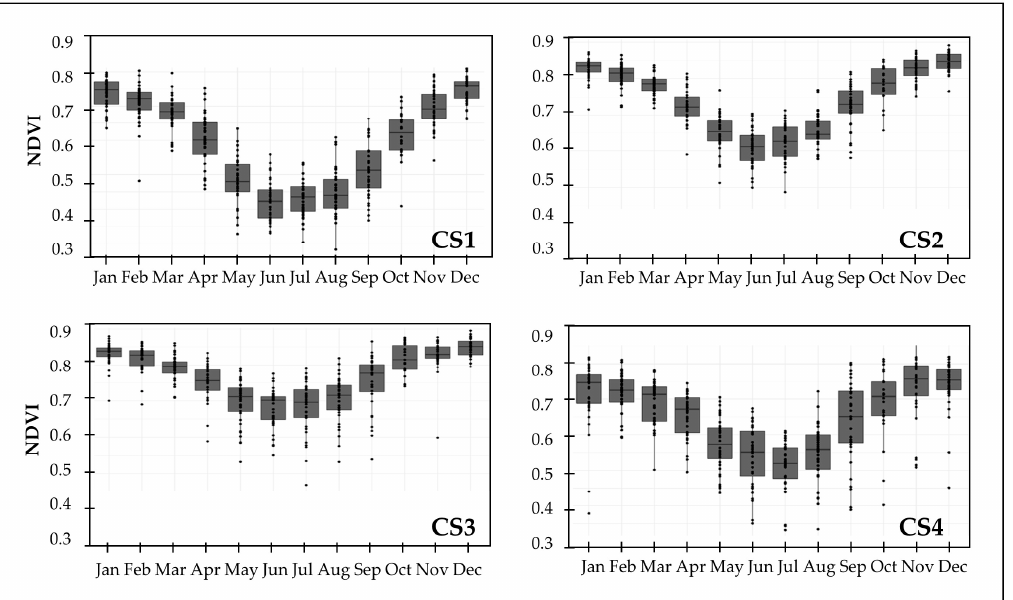
Figure 6. Monthly NDVI box diagram observed at CS1–CS4 during 2001–2018.